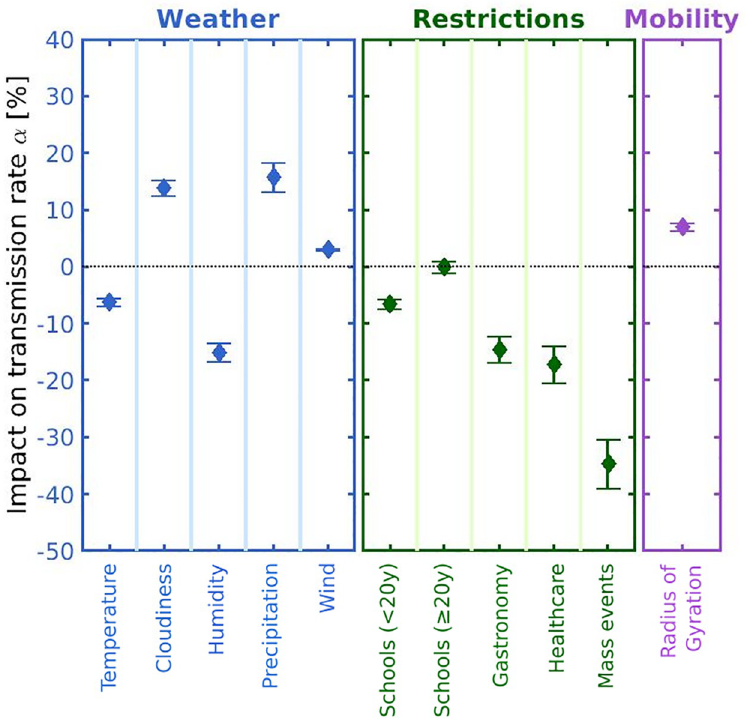
Fig 3. Summary of effect sizes of the input variables. Impacts on the transmission rate are shown in percent for weather variables (blue), NPIs (green) and mobility (magenta). Results for weather and mobility timeseries refer to changes in α for a unit change of one SD in the input. NPIs targeting large gatherings, temperature and humidity show the strongest transmission rate reductions whereas cloudiness leads to the strongest increase. Error bars denote the